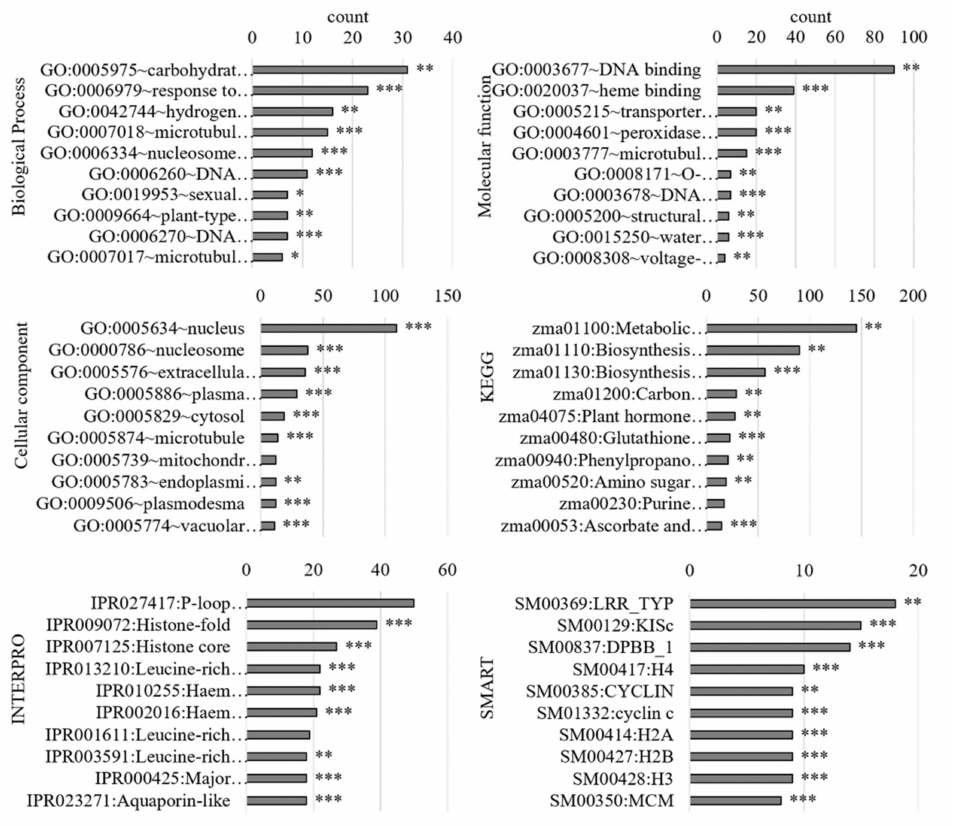
Figure 4. Gene-set enrichment analysis of maize roots under 24 h of hypoxia using DAVID. Dif- ferentially expressed genes were used to perform gene-set enrichment (GO) analyses with DAVID regarding the GO terms “biological process”, “molecular function”, and “cellular component”. In addition, KEGG pathways and domain analyses with INTERPRO and SMART were performed. The top 10 terms of each category with the corresponding number of genes (count) are shown in the graph with the p -values as asterisks ( p < 0.05 *, p < 0.01 **, p < 0.001 ***). LRR_TYP,